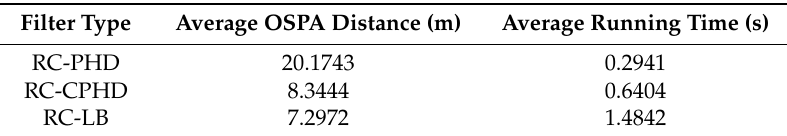
Figure 13. Tracking performance of the filters versus detection probability for a target on curved road: ( a ) average OSPA of the filters ( b ) running time of the filters. Table 8. Average OSPA distance and running time of different filters with different clutter rates when the detection probability is equal to